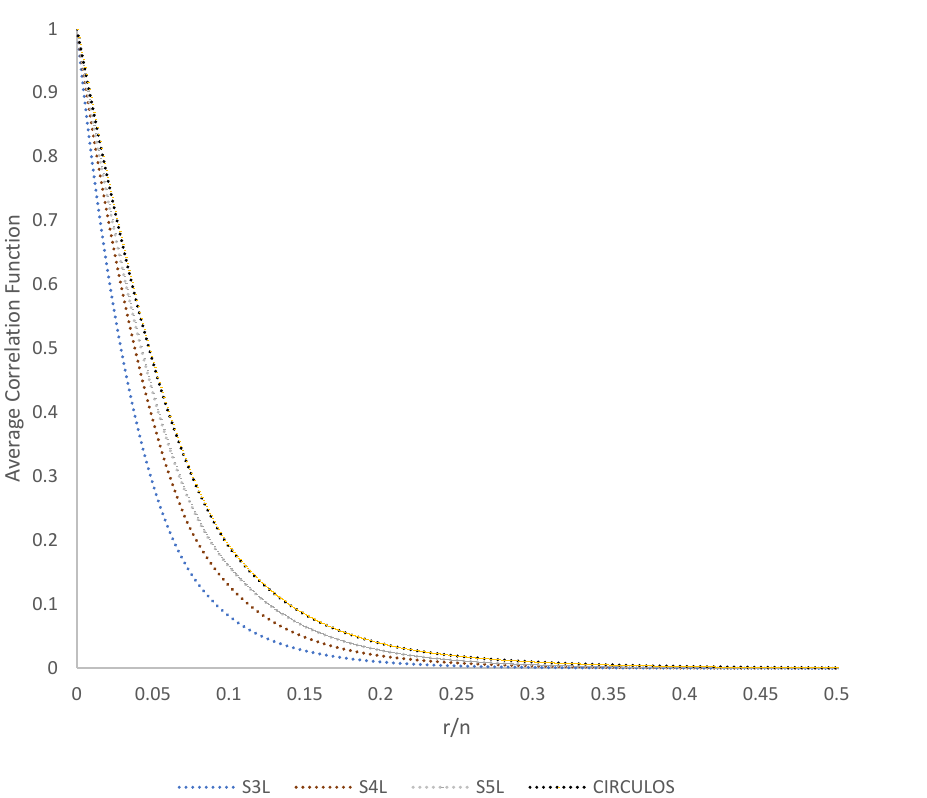
Figure 8. Average correlation functions normalized for a ten PSA realization for every configuration (S3L, S4L, S5L, and SC) generated along the process presented in Figure 4 in a surface fraction range of 10% to 90% for the agglomerate phase.